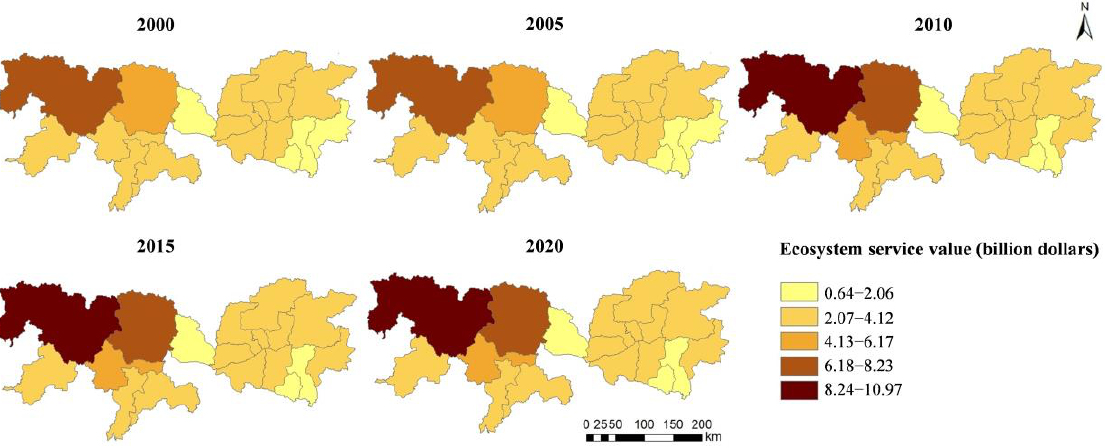
Figure 3. Spatiotemporal distribution of ecosystem service value in the ORTTR from 2000 to 2020.